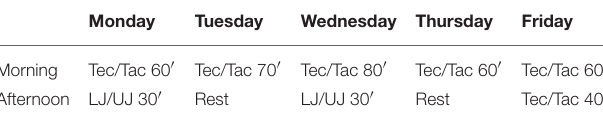
TABLE 1 | Typical weekly training schedule for the young soccer